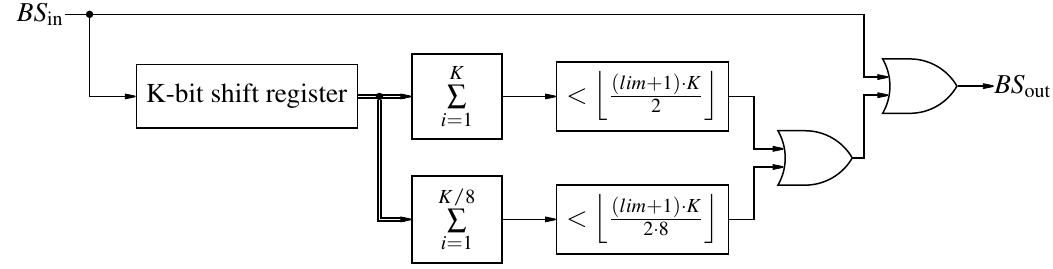
Figure 28. Limiting the lower value of a bit-stream using delay taps for averaging.